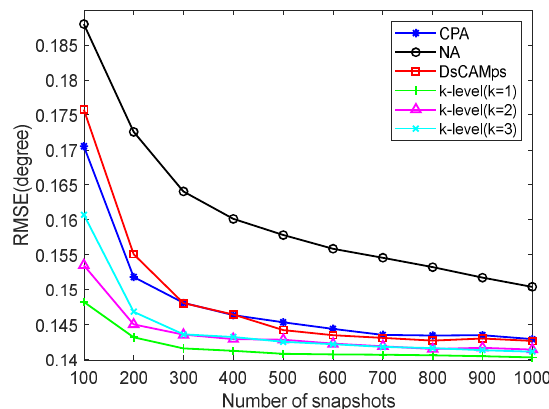
Figure 10. RMSE of snapshot number with SNR being 0dB.